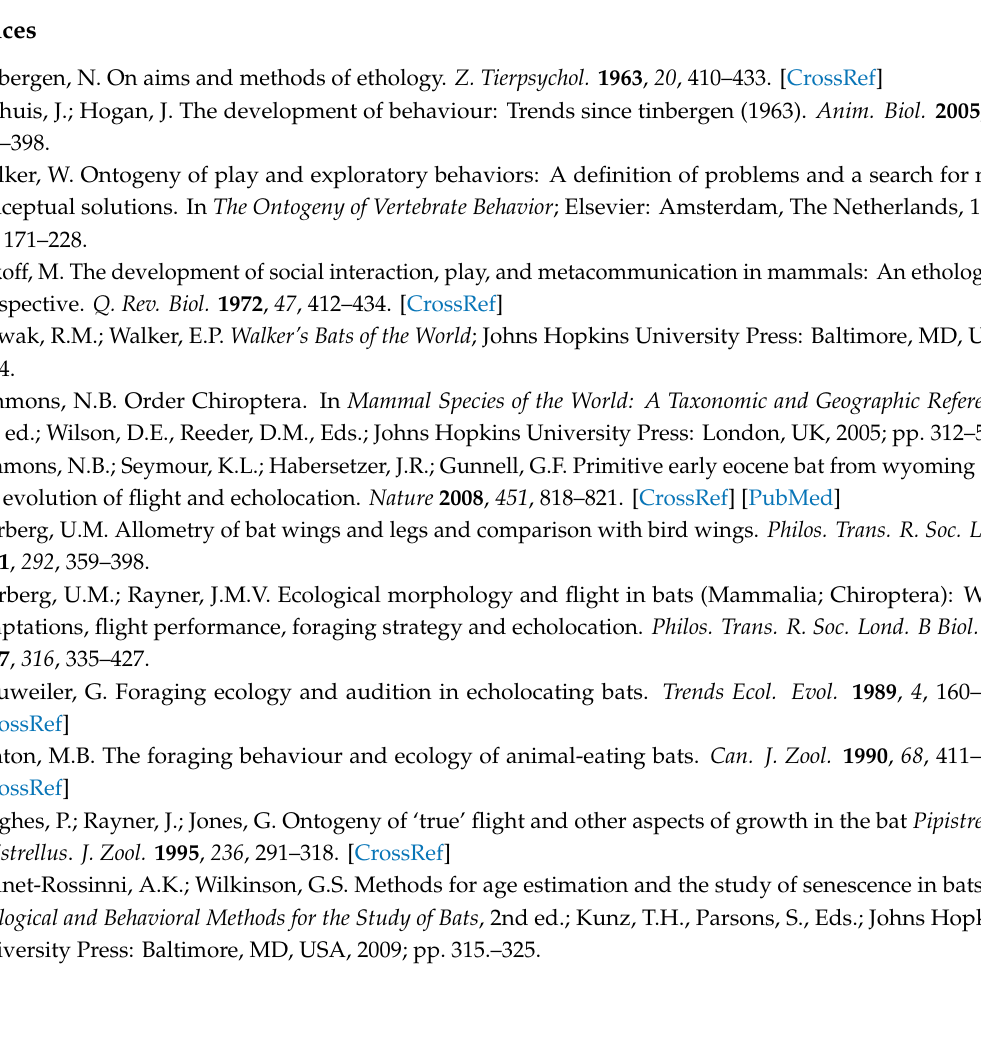
Table S1: The number of occurrences of the di ff erent types of behaviours and scaled mass index in the early development of the Asian parti-coloured bat (Vespertilio sinensis) (mean ± standard deviation), Table S2: First flight and flight acquisition times of infant Asian parti-coloured bats (Vespertilio sinensis), Video S3: A video providing a better visualization of the four behaviours of young